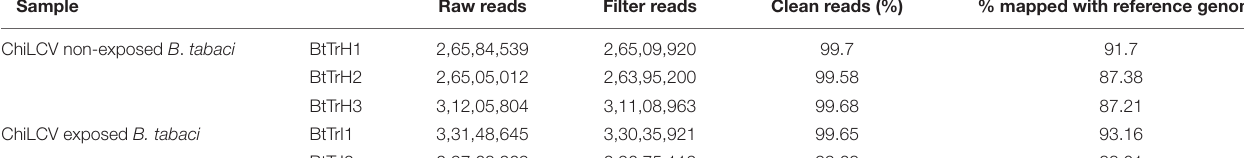
TABLE 1 | Summary of RNA-Seq data obtained from ChiLCV-exposed and non-exposed B. tabaci Asia II 1. Sample